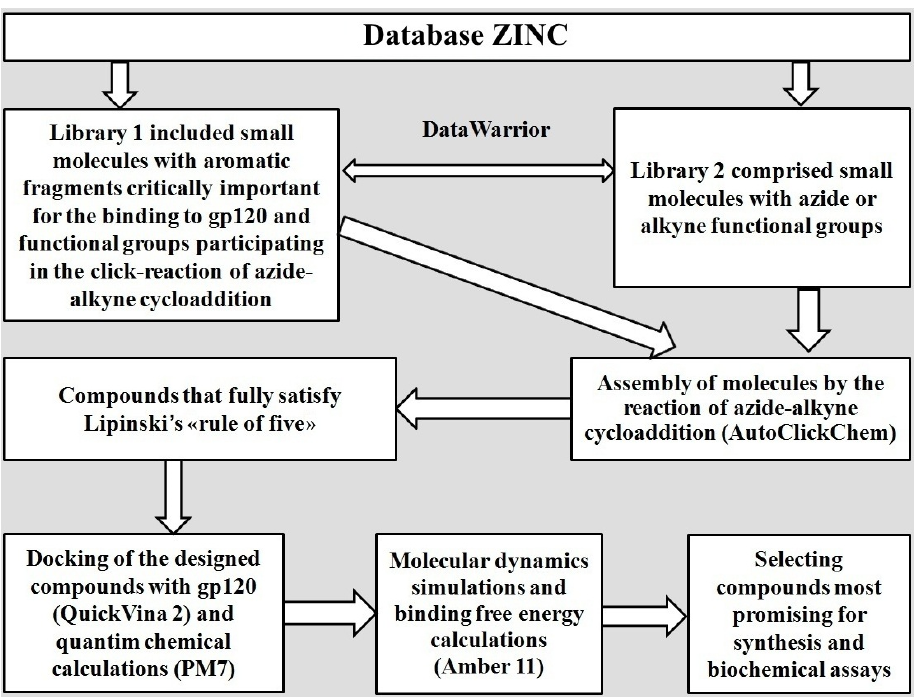
Figure 1. The algorithm scheme used for the identification of CD4-mimetic candidates.